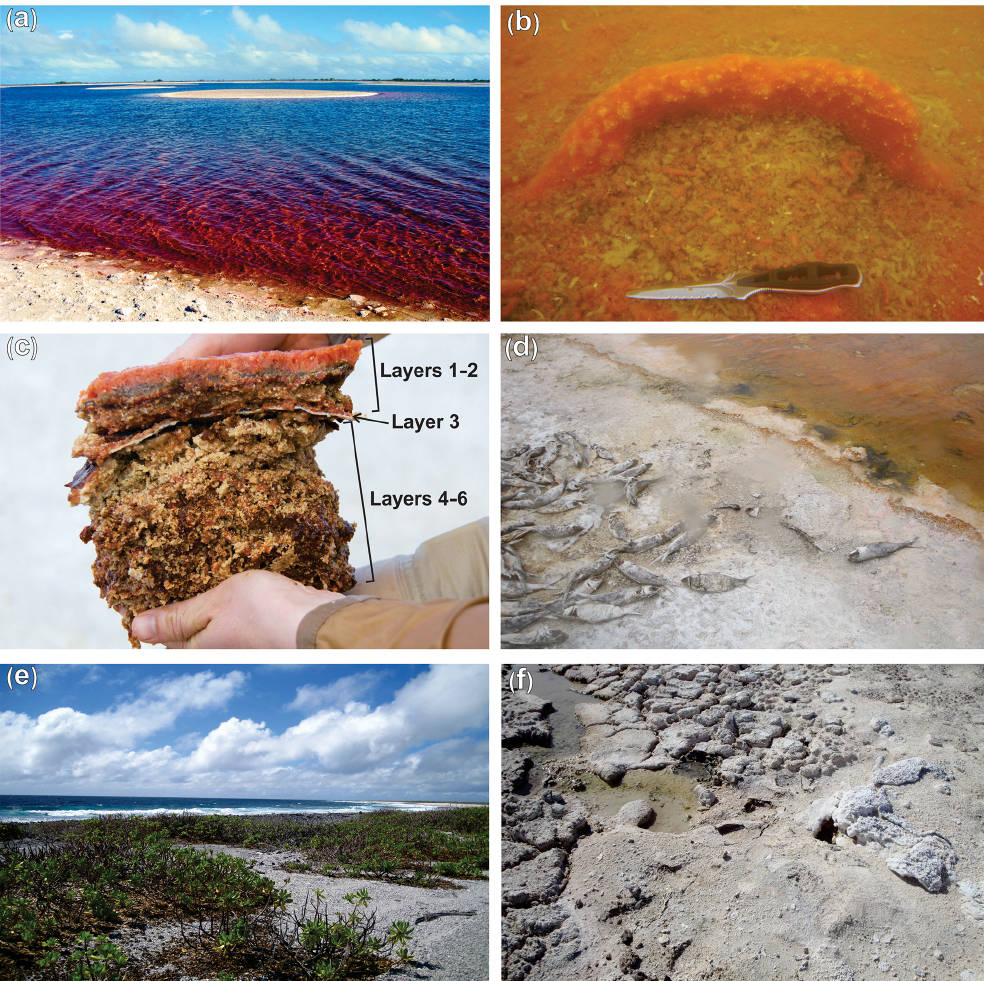
Figure 2. Field images. (a) General view of hypersaline Lake 2 in Kiritimati. (b) Underwater photograph showing an example of a currently active, orange-colored microbial mat at the bottom of the lake. (c) The microbial mat sampled for this study, with clear color zonation; note the whitish mineral crust (layer 3) separating the upper younger growth phase from the older, more mineralized layers. (d) Lakeshore showing dead fish. (e) Vegetation around the lake area. (f) Sampling site for the hypersaline Lake 22 mat (Shen et al.,